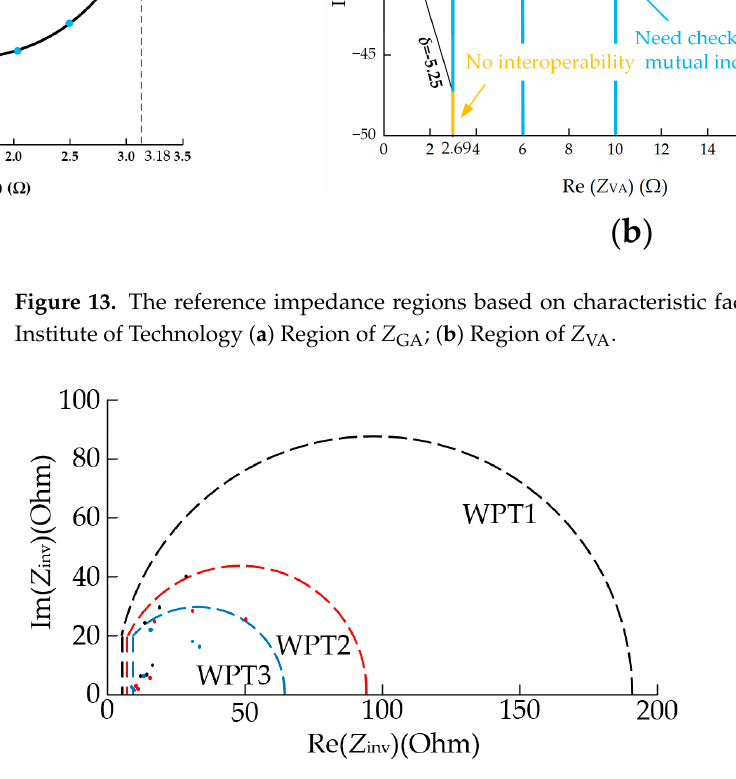
Figure 15. Improved impedance region proposed by the Tiangong University. However, the impedance angle is difficult to measure accurately at high frequencies. To solve this problem, [91] proposed an impedance measurement method based on power decomposition, as shown in Figure 16. The input power was decomposed to calculate the phase difference, significantly improving the measurement accuracy. Moreover, [92] also proposed a novel method to measure high-power VA impedance. By selecting several different test ports and parameters to reconstruct the port impedance expression, a meas- urement method with lower uncertainty was realized.